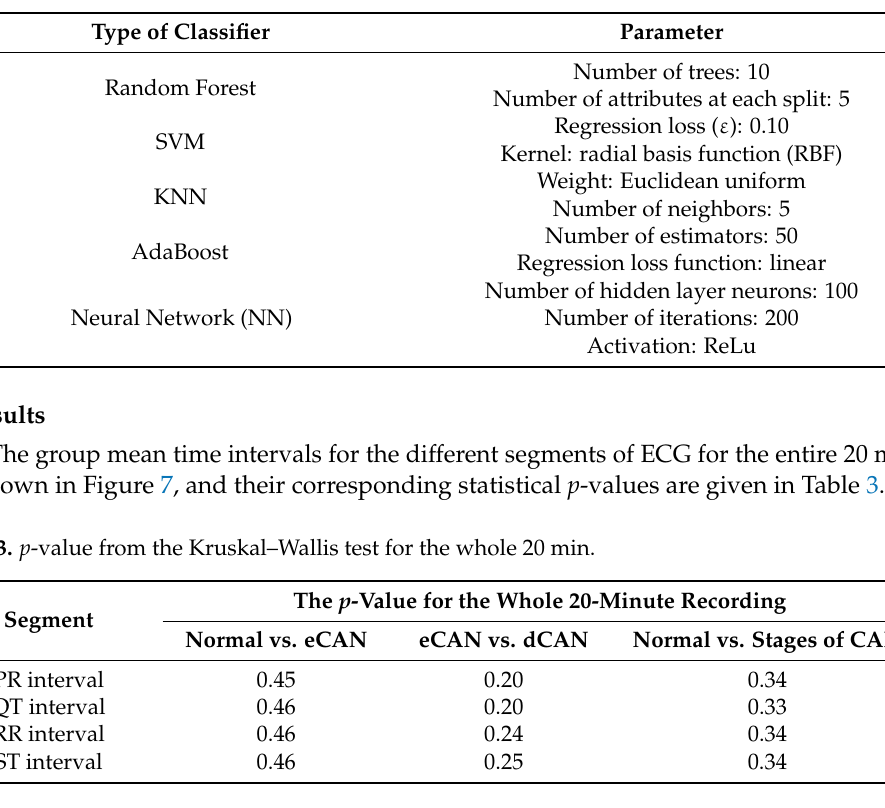
Figure 6. Classifier model with ranking estimator. Note: Data sample → Data indicates the data given to the classifier model, and Remaining data → Data indicates the test data given to the prediction. Model → Predictors indicates the trained data from model given to prediction. Table 2. Initial learning parameters for classifier model.